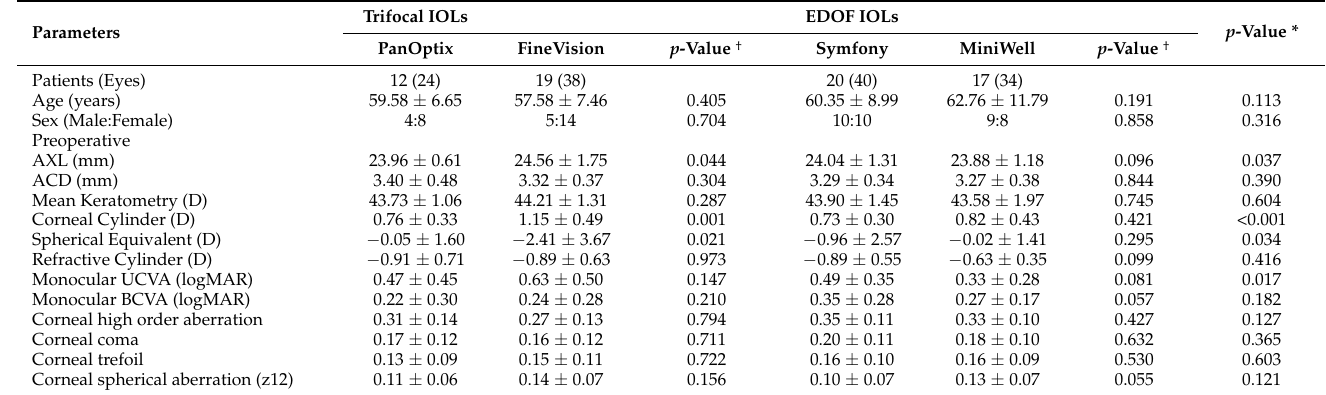
Table 1. Baseline demographics of the study participants, classified according to